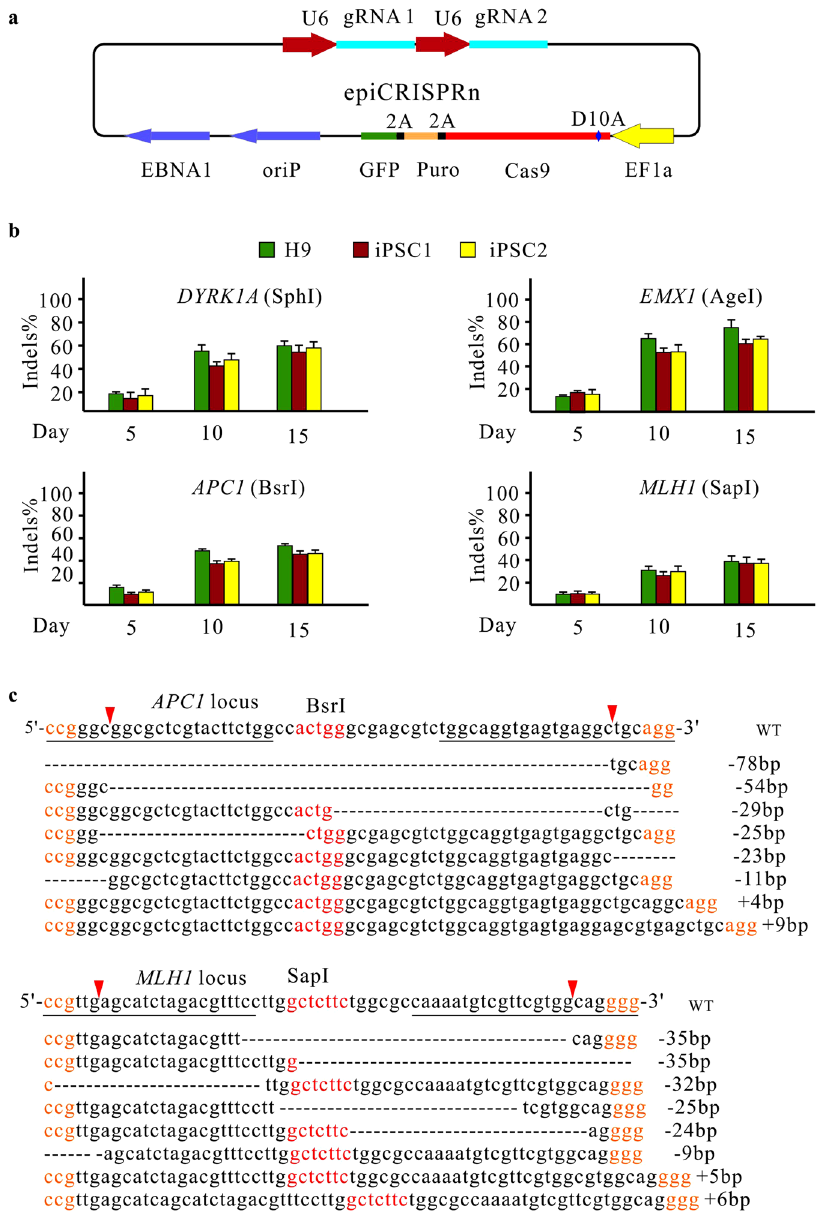
Figure 6. An epiCRISPRn system for efficient double-nicking. ( a ) Schematic of the epiCRISPRn vector design. A D10A mutation was introduced into the epiCRIPSR vector. ( b ) RFLP analysis of the indel rates generated by the epiCRISPRn system targeting DYRK1A , EMX1 , AAVS1 , VEGFA , APC1 and MLH1 loci (n = 3, error bars show mean ± S.D.). ( c ) Representative indel sequences generated by the epiCRISPRn at APC1 and MLH1 loci. The size of indels is shown on the right. The gRNA sequence is underlined; the PAM sequence is shown in orange; the restriction sites are shown in red, the red triangles indicate Cas9 cutting